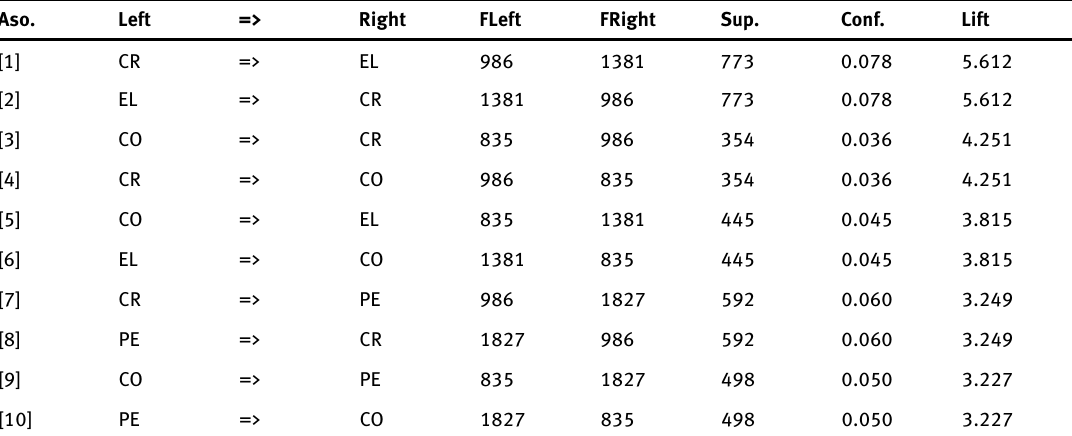
Table 5. Sample of association measures between countries based on the Varilex-R database.